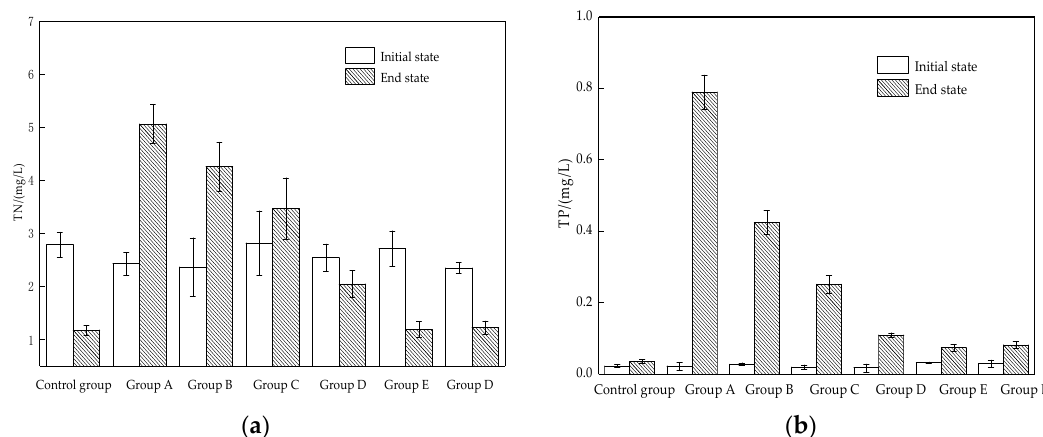
Figure 9. Changes in the nutrient concentrations in water at the initial and end state of the macrophyte decay period: ( a ) TN and ( b ) TP.